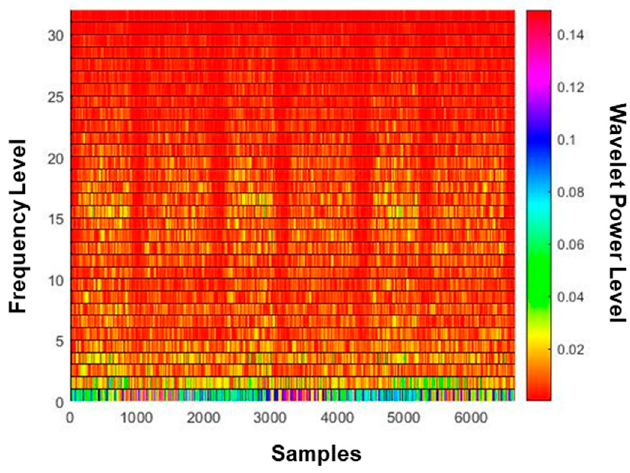
Figure 3. Example of subtracted spectrogram.